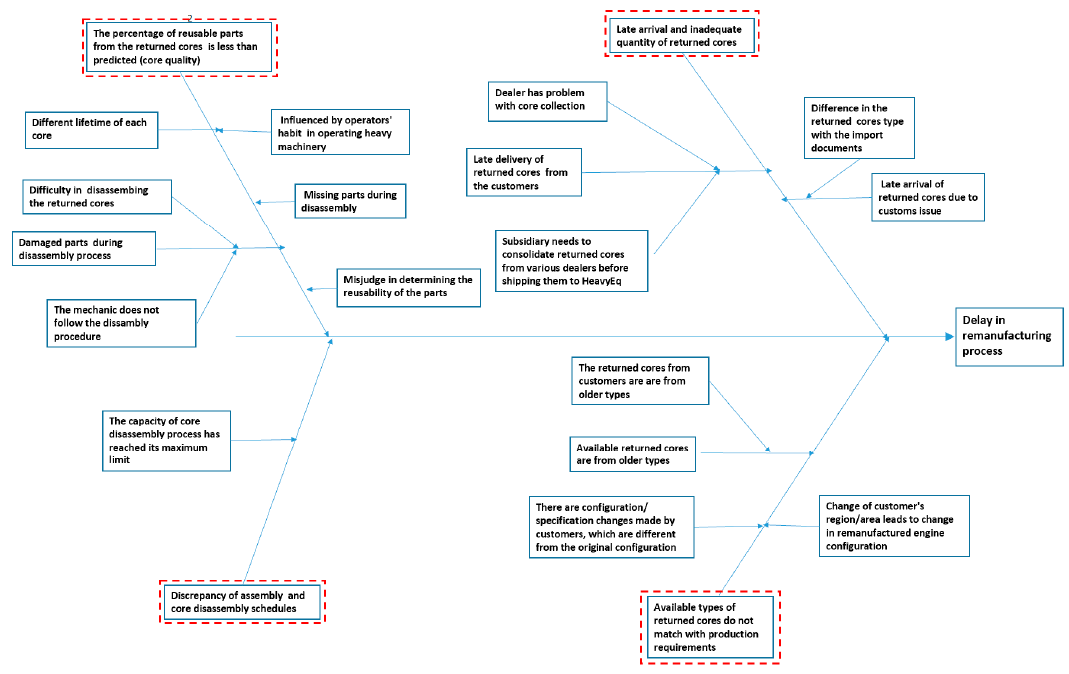
Figure 3. The fishbone diagram. Table 6. The arrival of returned cores one month before the production time (October 2015). Arrival Time Number of